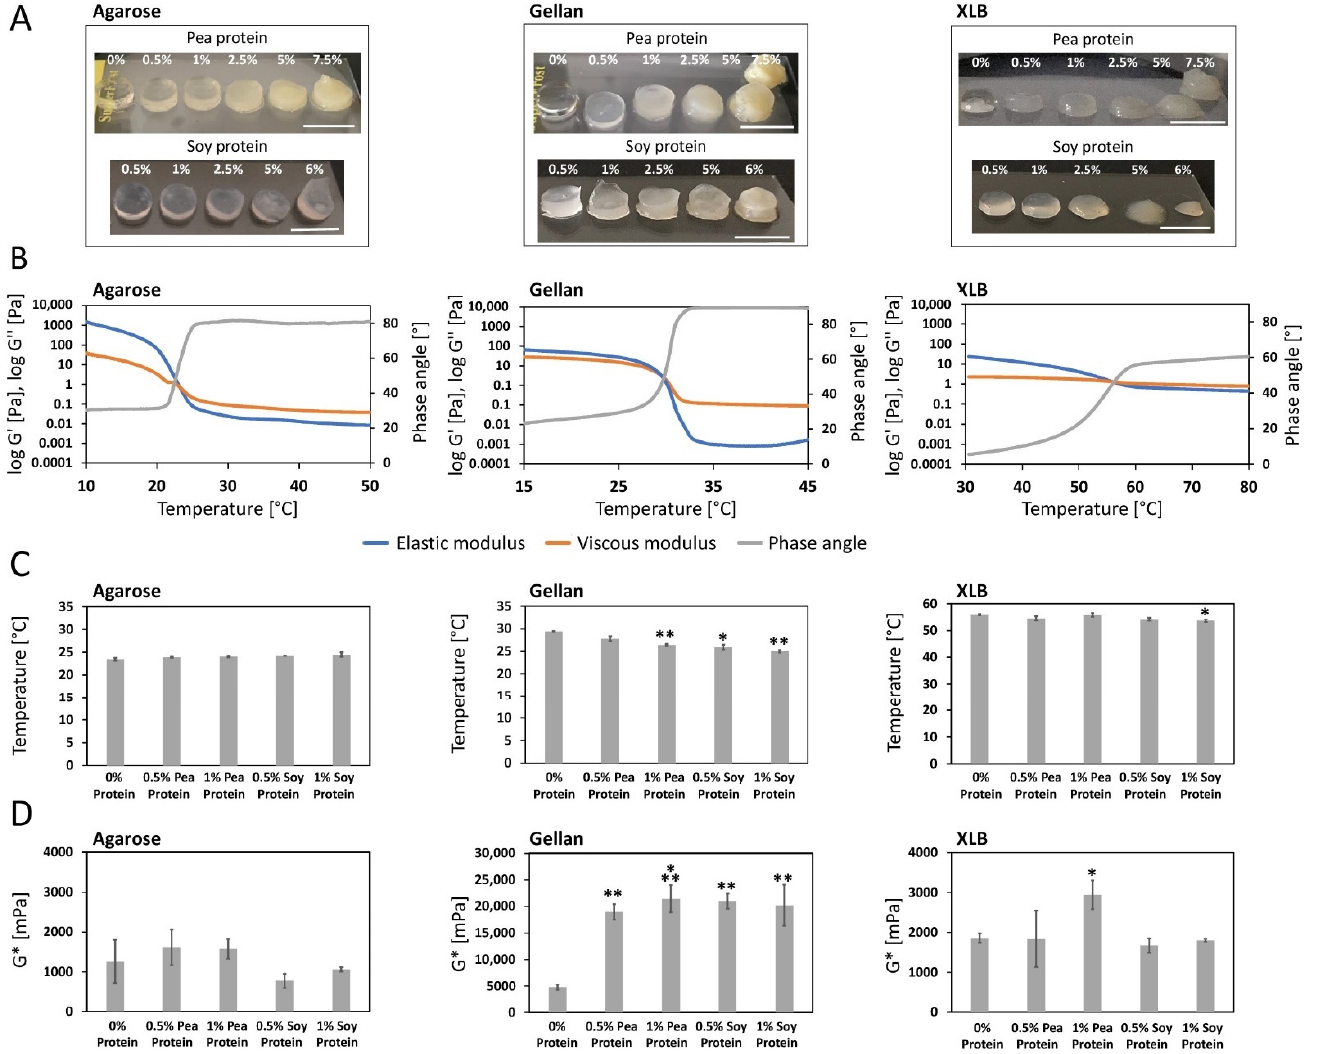
Figure 2. Sol-gel transition properties of agarose, gellan and XLB gels blended with pea or soy protein. ( A ) Gel formation of gels mixed with 0–7.5% pea protein and 0–6% soy protein, respectively. Scale bar: 10 mm. ( B ) Rheological curves of protein-free agarose, gellan and XLB with elastic and viscous modulus and phase angle versus temperature (1.0 Hz frequency and 1 Pa shear stress). ( C ) Temperature-dependent gelation points of polysaccharides blended with 0%, 0.5% and 1% pea or soy protein. (n = 3, two-sided t student test * p < 0.05, ** p < 0.01, respectively to 0% values). ( D ) Complex modulus at gelation points of gels blended with 0%, 0,5% and 1% pea or soy protein (n = 3, two-sided t student test * p < 0.05, ** p < 0.01, *** p < 0.001, respectively to 0% values). Error bars represent standard deviations.